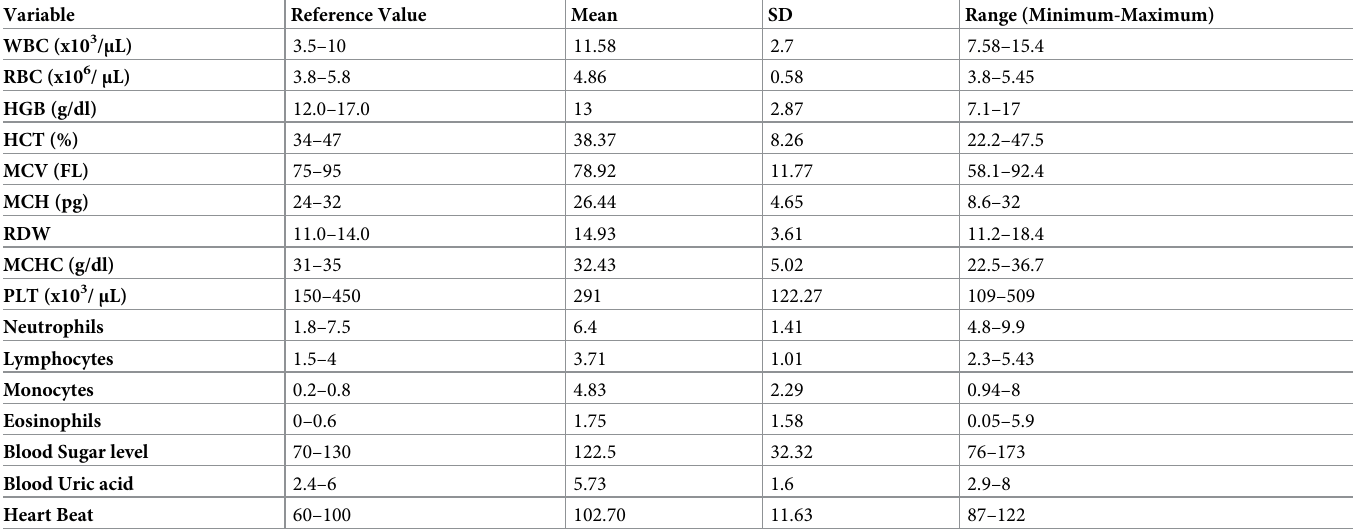
Table 8. Clinical assessment with respect to sleep disorder.